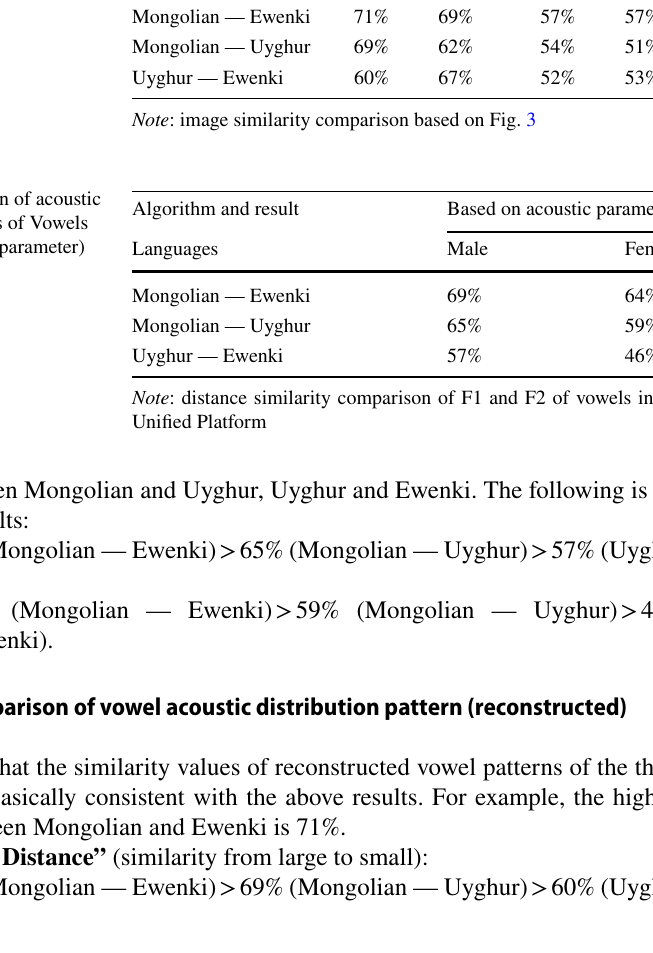
Table 2 Comparison of acoustic distribution patterns of reconstructed vowels in three languages (reconstructed)